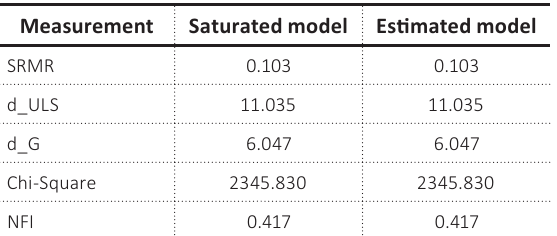
Table 7. Fit summary